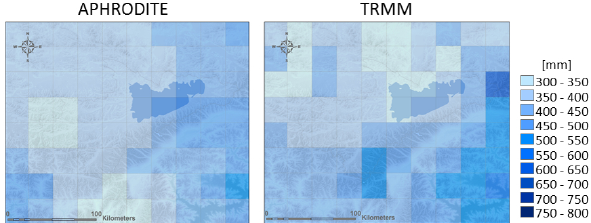
Fig. 8. Comparison of annual mean precipitation data of APHRODITE and TRMM for the period 1999–2007.